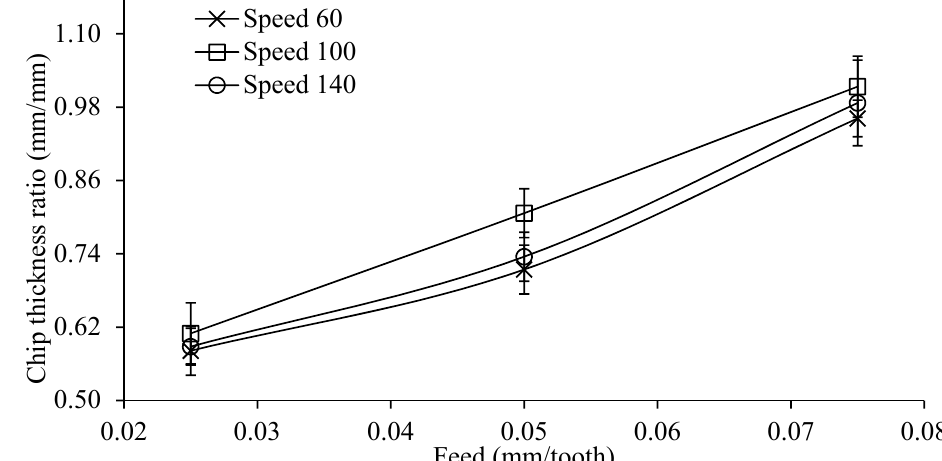
Figure 4. Chip thickness ratio of nanoparticles reinforced with Al-based metal matrix composites (nano-MMCs) at different feeds and speeds.